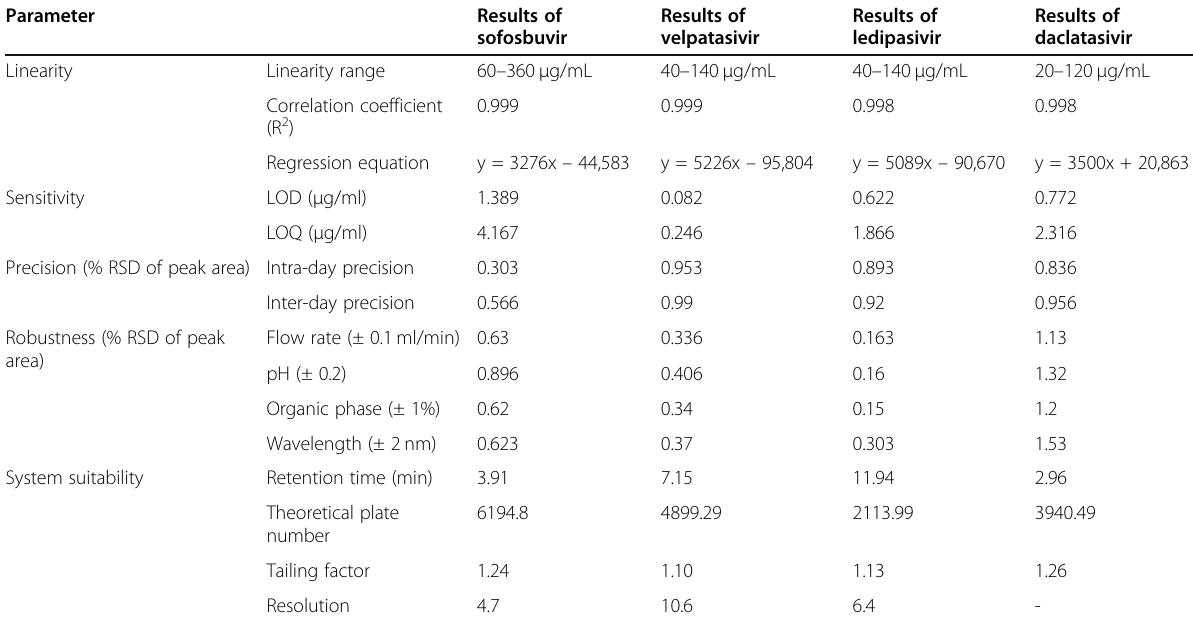
Table 7 Results of the method